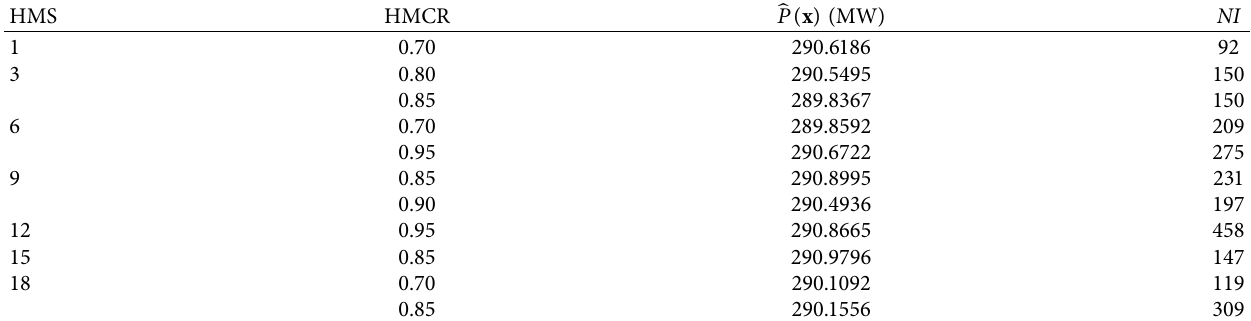
diferent values of HMS and max